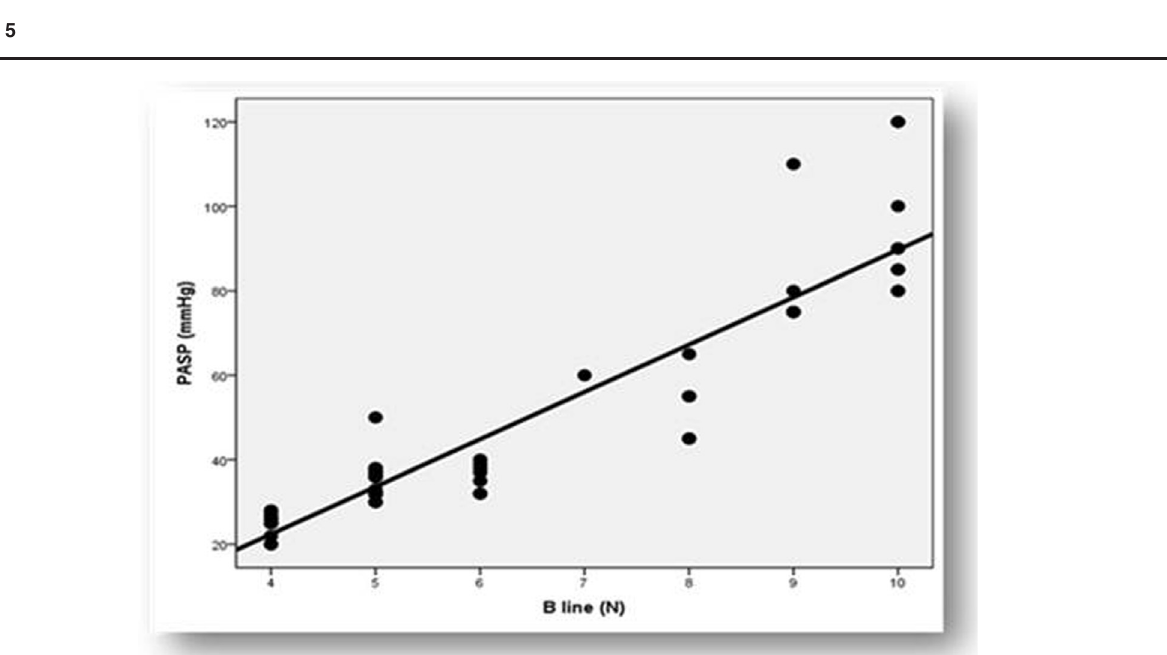
The relation between B-line number and pulmonary artery systolic